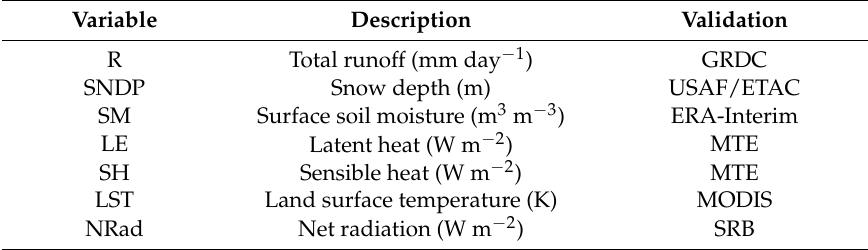
Table 1. Validation Data